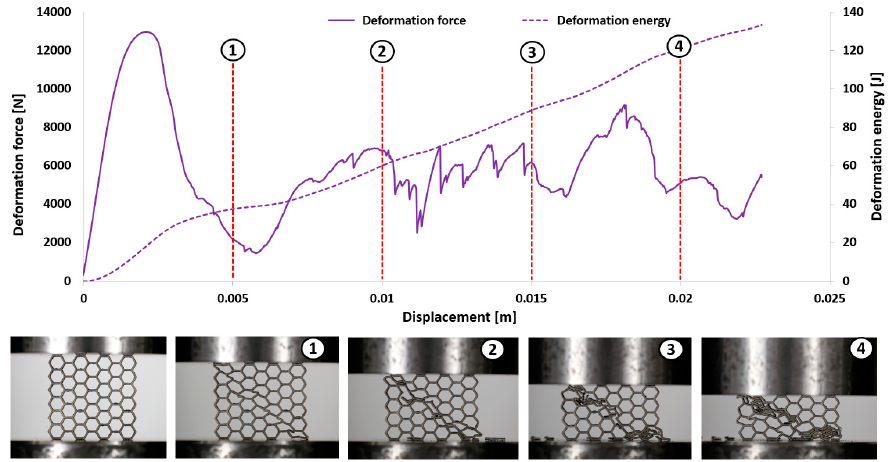
Figure 15. Deformation process of specimen No. 4 manufactured additively with LENS (1–4 stages of deformation during static compression test).